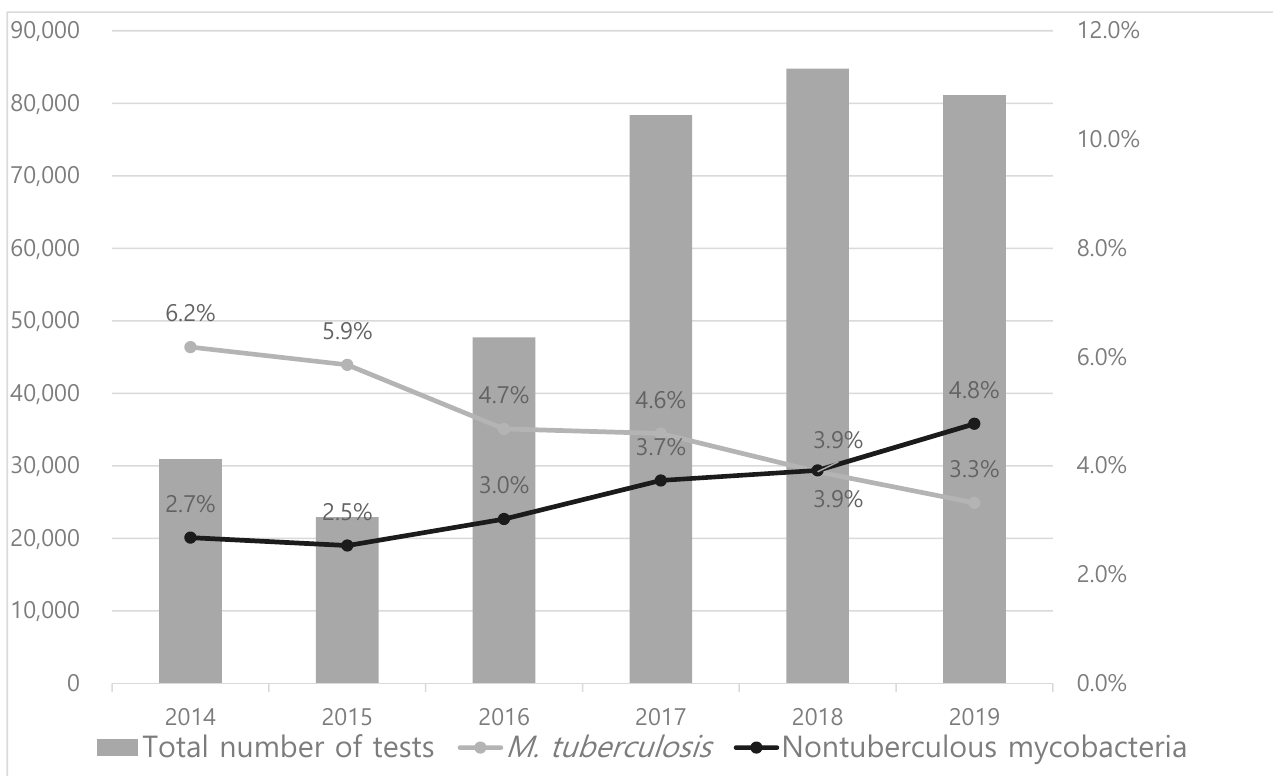
Figure 1. Annual trends of isolation rate of nontuberculous mycobacteria, compared to that of M. tuberculosis . M. tuberculosis: Mycobacterium tuberculosis.